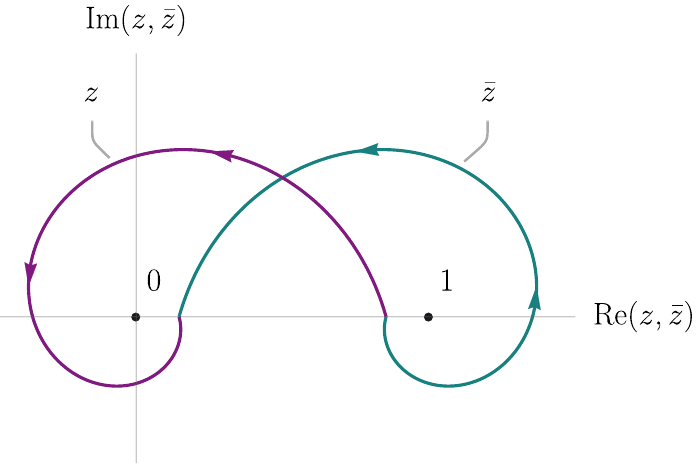
Figure 5 . The path traversed in the complex plane by the variables z (purple) and ¯ z (green) as we lower τ from π to 0 at fixed θ . The vertical scale in these graphs is greatly exaggerated to make them visible. The actual curves should be thought of as hugging the real axis except in the neighbourhood of the branch points which they circle in the manner shown in this